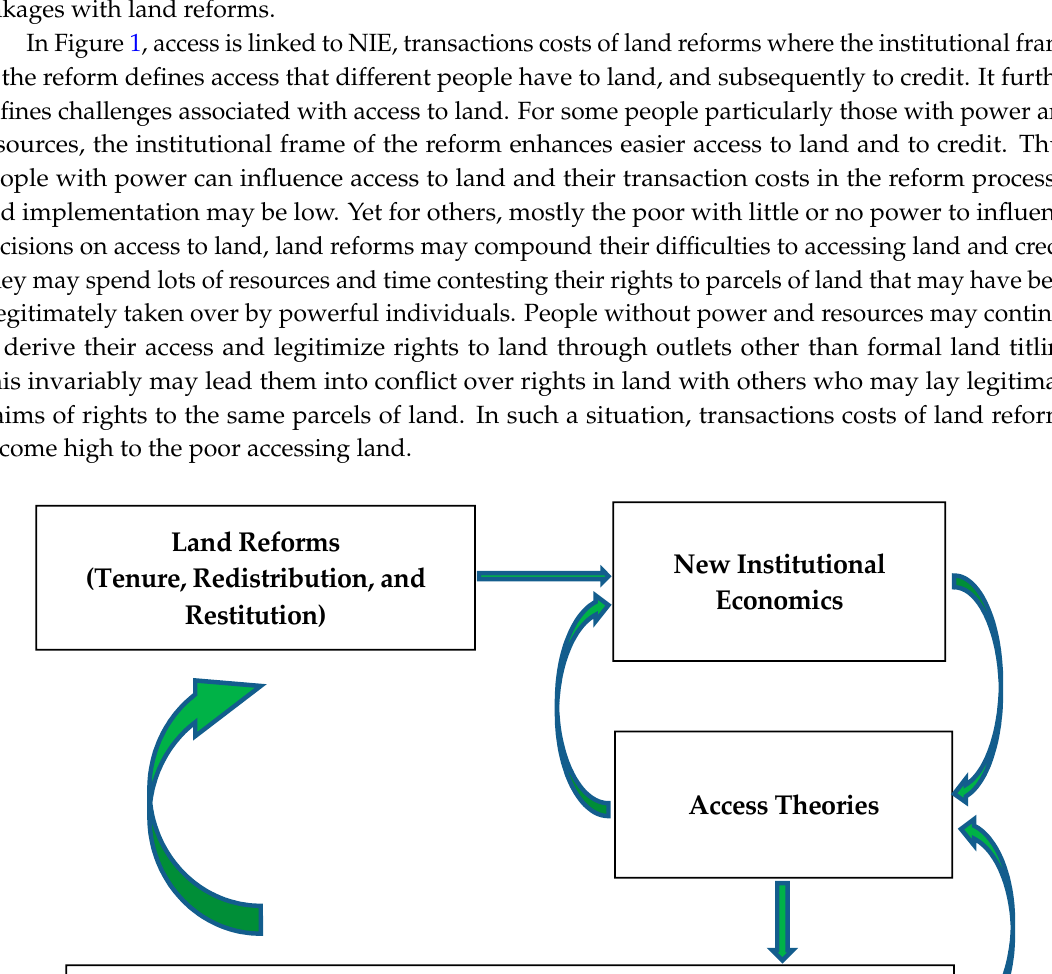
Figure 1. A diagrammatic representation of the analytical framework applied to the case study countries.